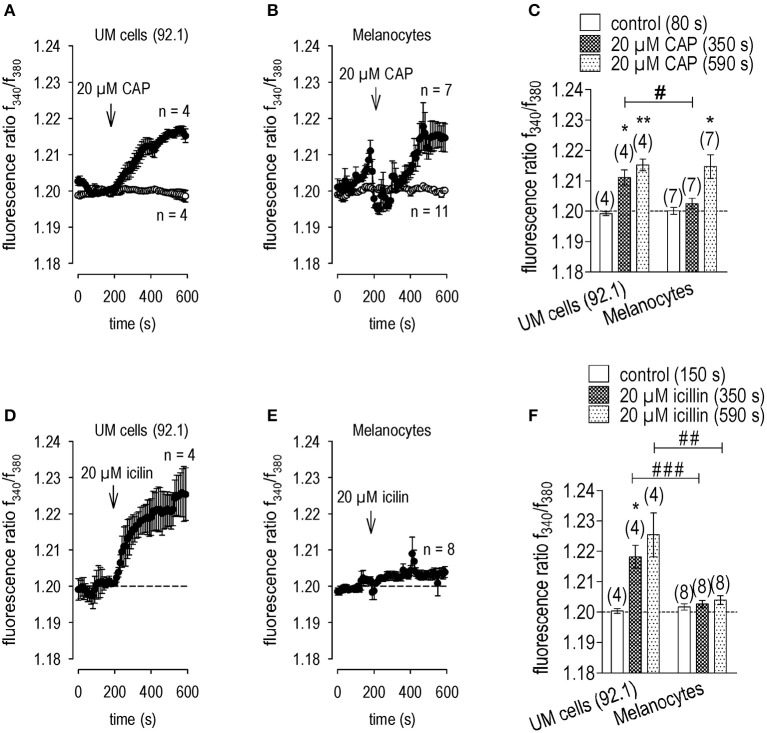
Larger functional TRPM8 expression in UM 92.1 than PM cells. Drug additions were made at the indicated time points (arrows). Data are mean ± SEM of 4–8 experiments. (A) CAP (20 μM) induced an irreversible Ca2+ influx (n = 4) whereas non-treated control cells showed a constant Ca2+ baseline (n = 4). (B) The same effect could be observed in normal porcine melanocytes but with a time lag (n = 7; controls n = 11). (C) Summary of the experiments with CAP (n = 4–7). The asterisks (*) show significant differences between control and CAP (n = 4; 350s; *p < 0.05; n = 7; 590 s; **p < 0.01; paired tested). The hashtag shows a significant difference of the CAP effect at 350 s between UM 92.1 cells and melanocytes (n = 4-7; 590 s; #p < 0.05; unpaired tested). (D–F) Same experiments as shown in (A–C), but with icilin (20 μM) (n = 4–8). The icilin effect was markedly reduced in porcine melanocytes. The asterisks (*) show significant differences between control and icilin (n = 4; 350 s; *p < 0.05; paired tested). The hashtags (#) shows a significant difference of the icilin effect at 350 s and 590 s between UM 92.1 cells and melanocytes (n = 4–8; 350 s; ###p < 0.005; 590 s; ##p < 0.01; unpaired tested).